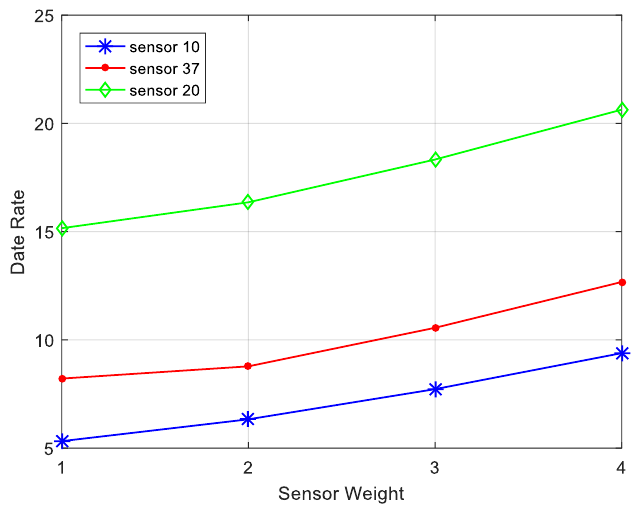
Figure 10. Impact of node weight on data rate.